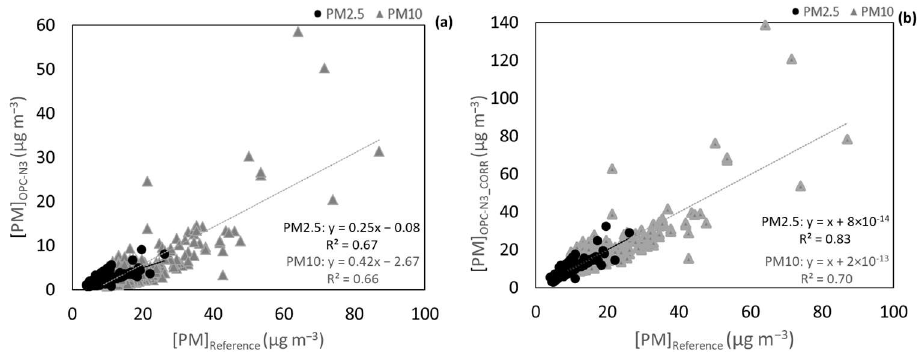
Figure 5. ( a ) Correlation between the OPC-N3 PM2.5 and PM10 concentrations and the correspondent concentrations measured by the DustTrak and ( b ) correlation between OPC-N3 PM2.5 and PM10 concentrations corrected with a MLR considering T and HR and concentrations measured by the DustTrak. Measurements done in an indoor environment with a vehicle exhaust as a pollution emission source.